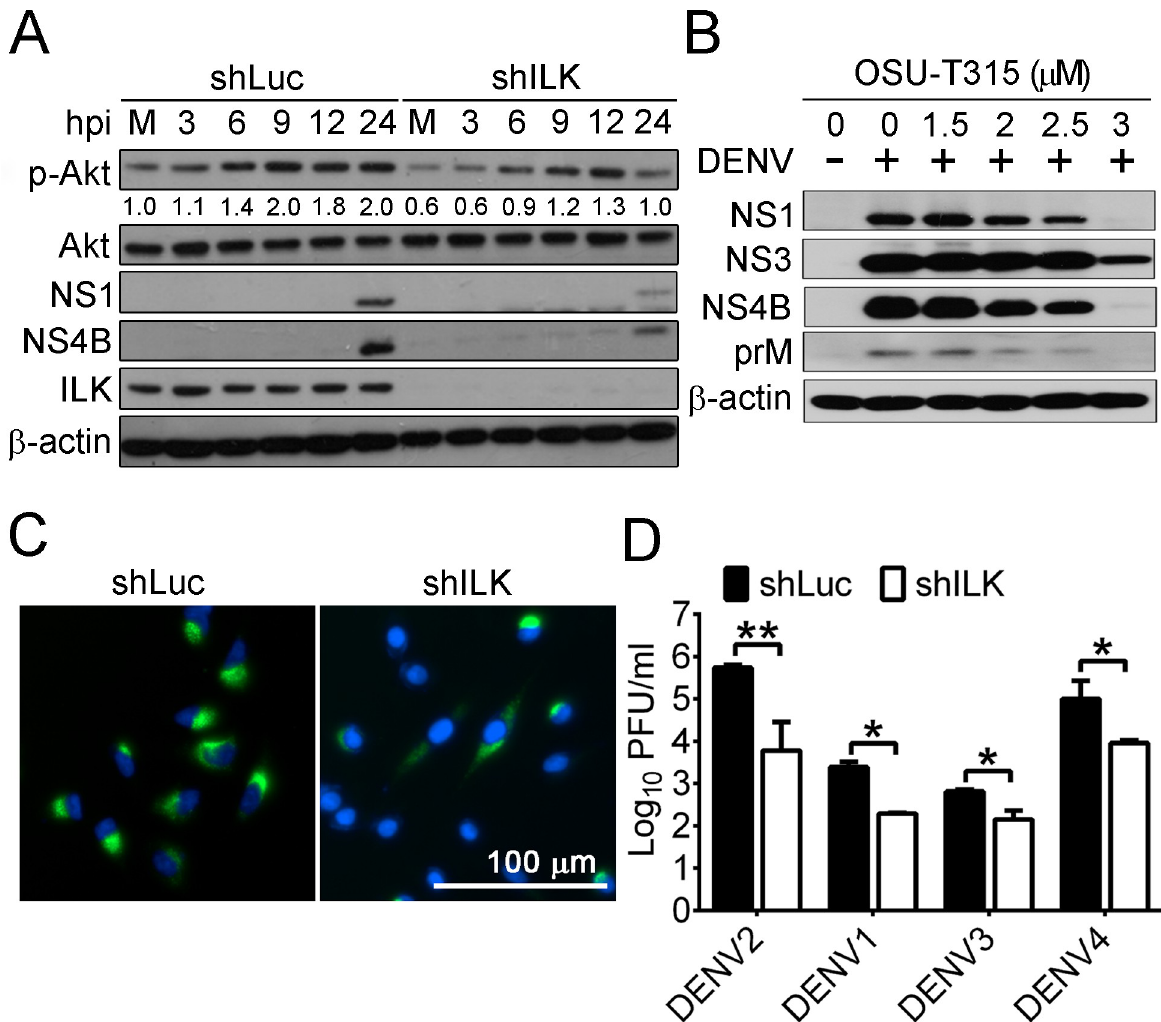
Fig 1. ILK knockdown reduces DENV infection. ( A ) Representative western blots of phosphorylated (p-) and indicated proteins in the mock- (M) and DENV serotype 2 (DENV2)-infected control (shLuc) and ILK knockdown (shILK) A549 cells at indicated hours post-infection (hpi) are shown. The ratios of phosphorylated to total Akt relative to mock-infected control cells are shown. ( B ) Representative western blots of indicated proteins in A549 cells infected without (-) or with (+) DENV2 and treated with indicated concentrations of OSU-T315 at 24 hpi are shown. ( C ) Representative images of DENV2-infected A549 cells stained with anti-dsRNA antibody (green) at 24 hpi are shown. Nuclei were counterstained with DAPI. ( D ) The viral yields in indicated control and ILK knockdown A549 cells infected with indicated serotypes of DENV at 24 hpi are shown. Data represent means + SD (error bars) in panel D. � p < 0.05, �� p <